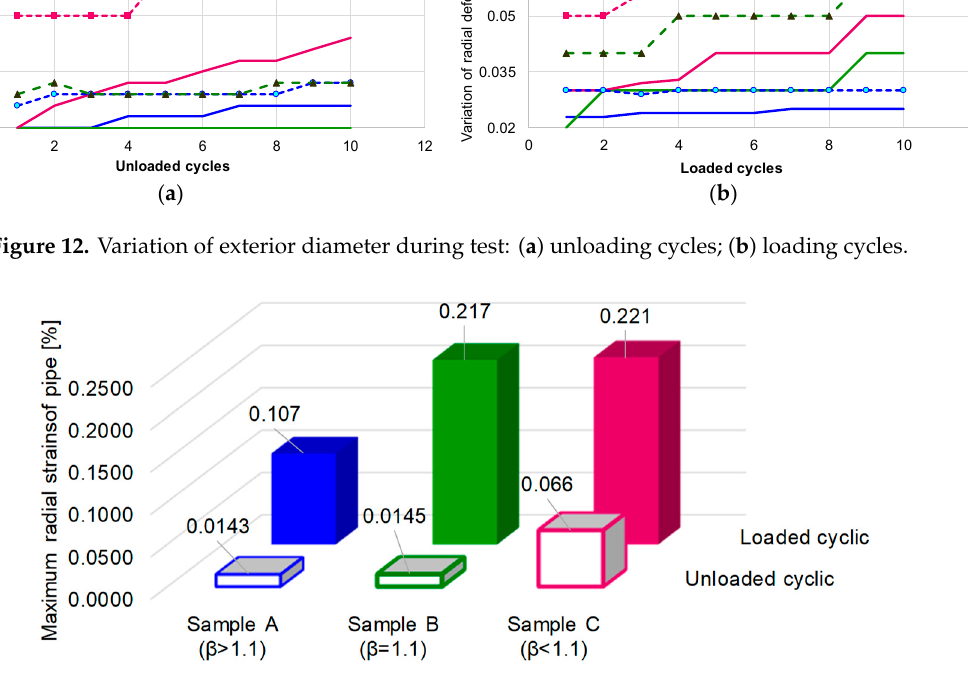
Figure 13. The final percentage of radial strain of tested pipes.